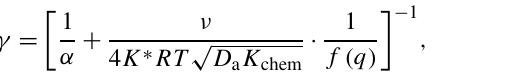
prediction on NVCs and Cl − , and these data along with the observed temperature and RH are further used as inputs to calculate PM 2 . 5 pH using the ISORROPIA II model (in the forward mode and metastable state). As gaseous NH 3 and HNO 3 observations are not available, we use aerosol NO − only as NO 3 input and estimated gaseous NH 3 values